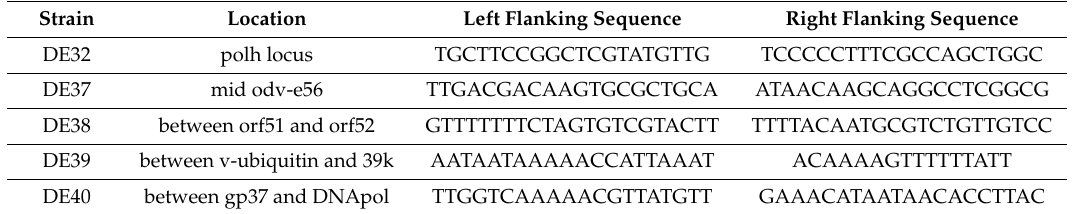
Table 1. attTn7 location in di ff erent